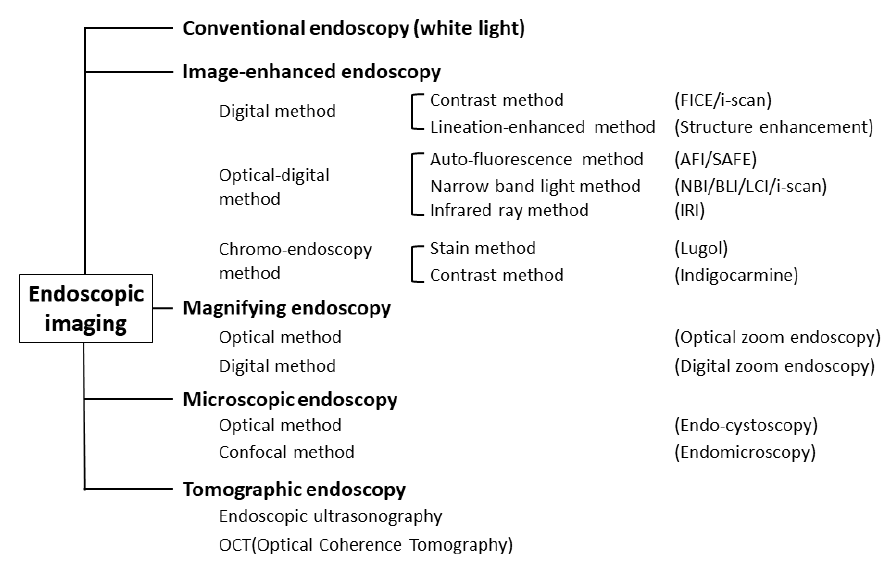
Figure 1. Classification of endoscopic techniques (adapted from Ref. [12]).